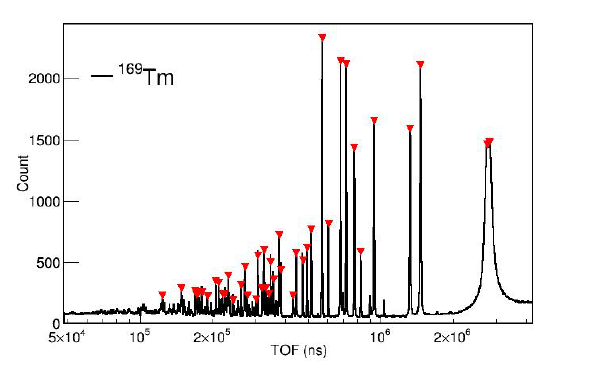
Fig.11 The TOF spectrum of 169 Tm Table.2 The experimental results and evaluated data of the 169 Tm resonance energies ENDF